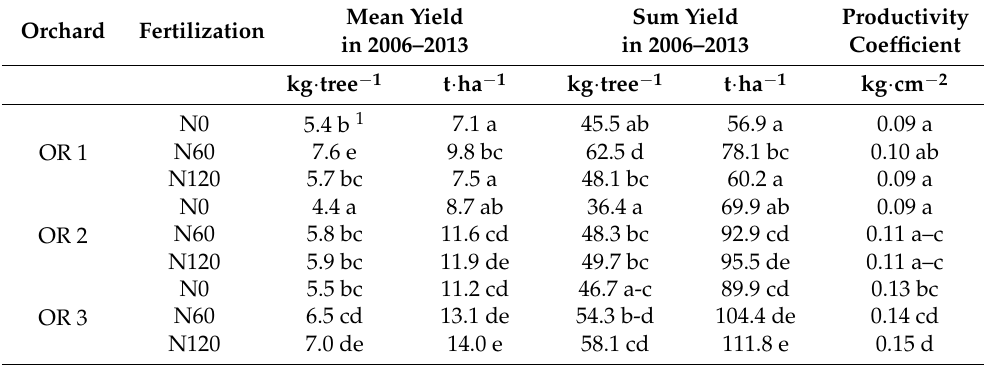
Table 5. Effect of nitrogen fertilization on tree